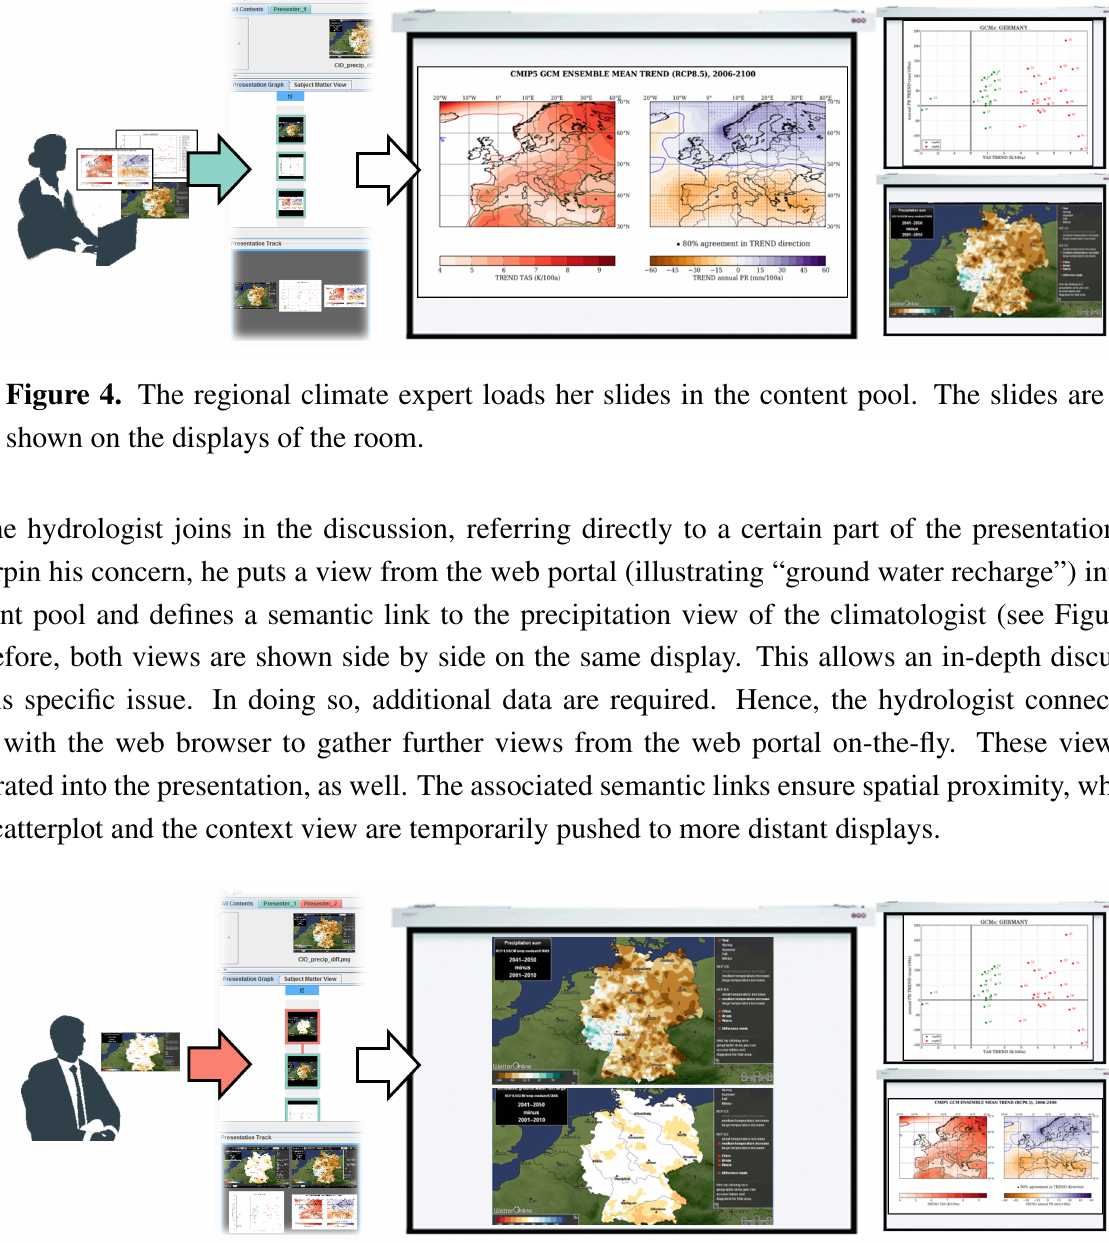
Figure 5. Situation after the hydrologist joins the discussion. Linked views are shown side by side on the same